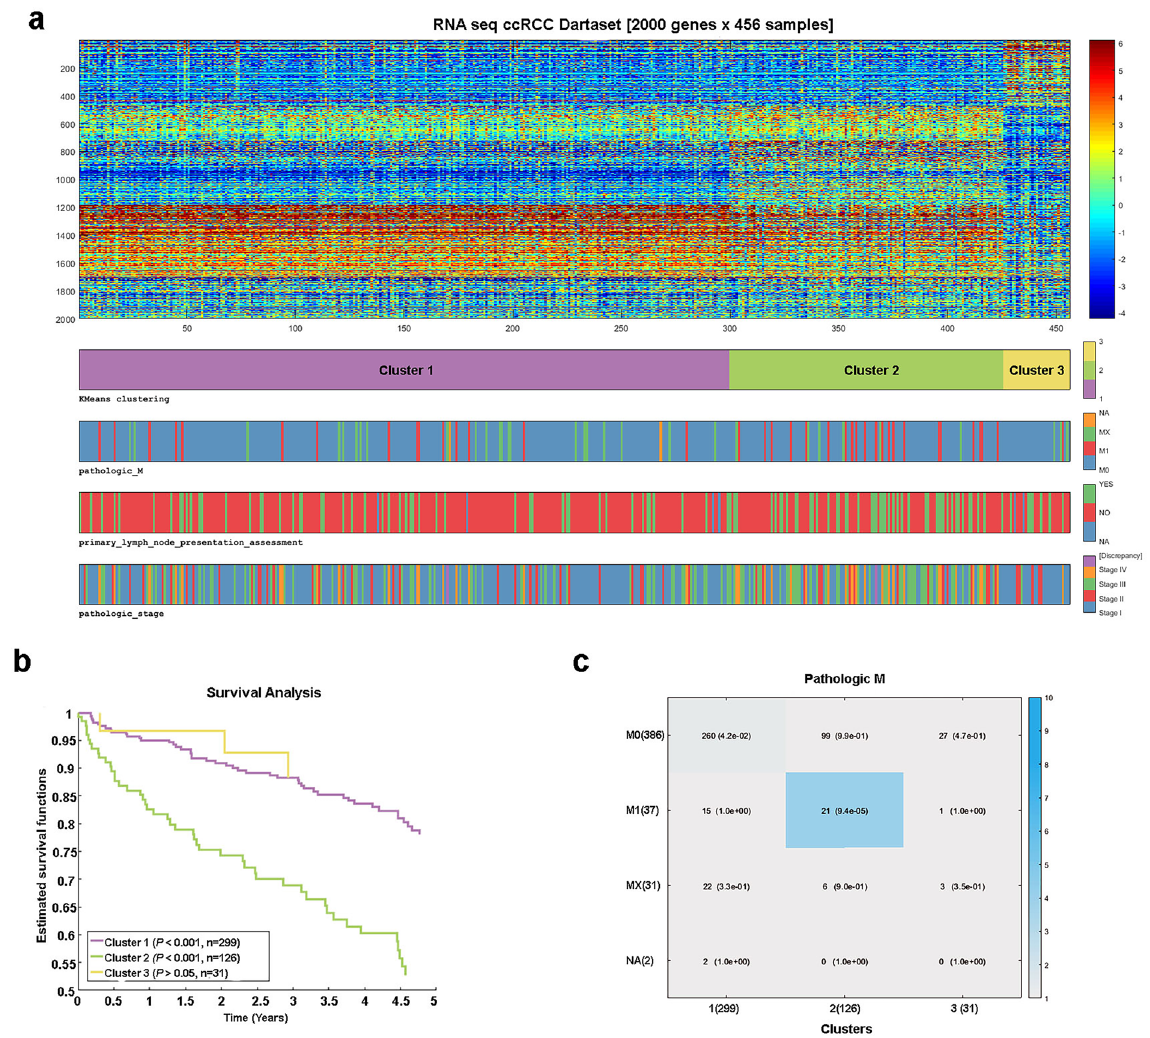
most variable genes in five gene clusters (matrix rows). Survival analysis for the three resulting clusters ( b ). The P -value shows the difference between the three groups according to the Logrank test. Distribution of samples with metastases depending on the cluster ( c ). The blue gradient increases towards a more significant P -value. The difference was considered significant at the P < 0.05. In Cluster 2, samples with the presence of metastases prevail, and in Cluster 1 with the absence of